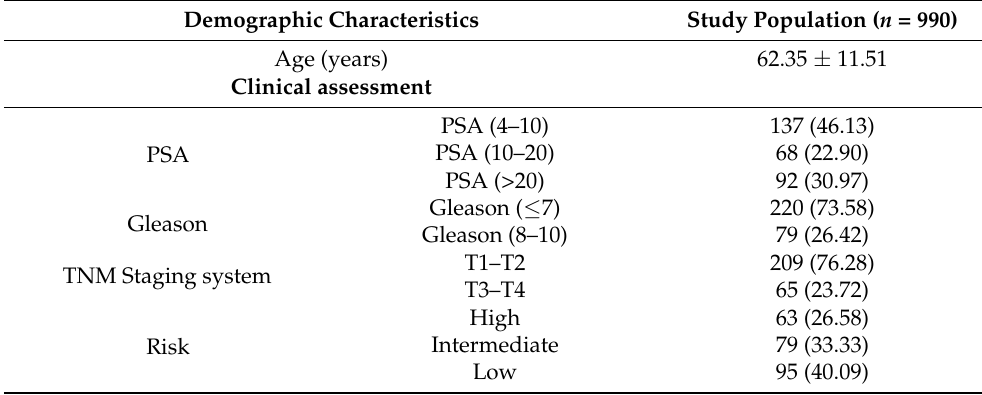
Table 1. Demographic and clinical characteristics of PCa